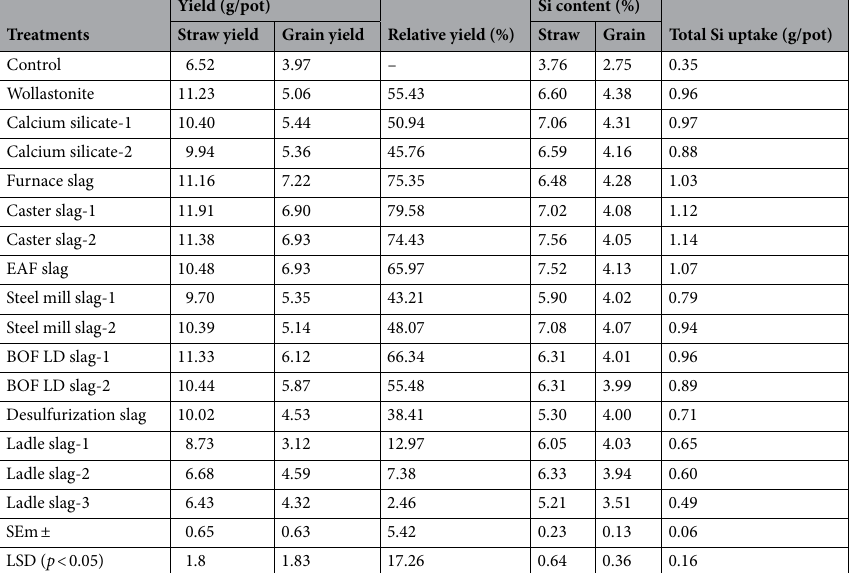
Properties of Si